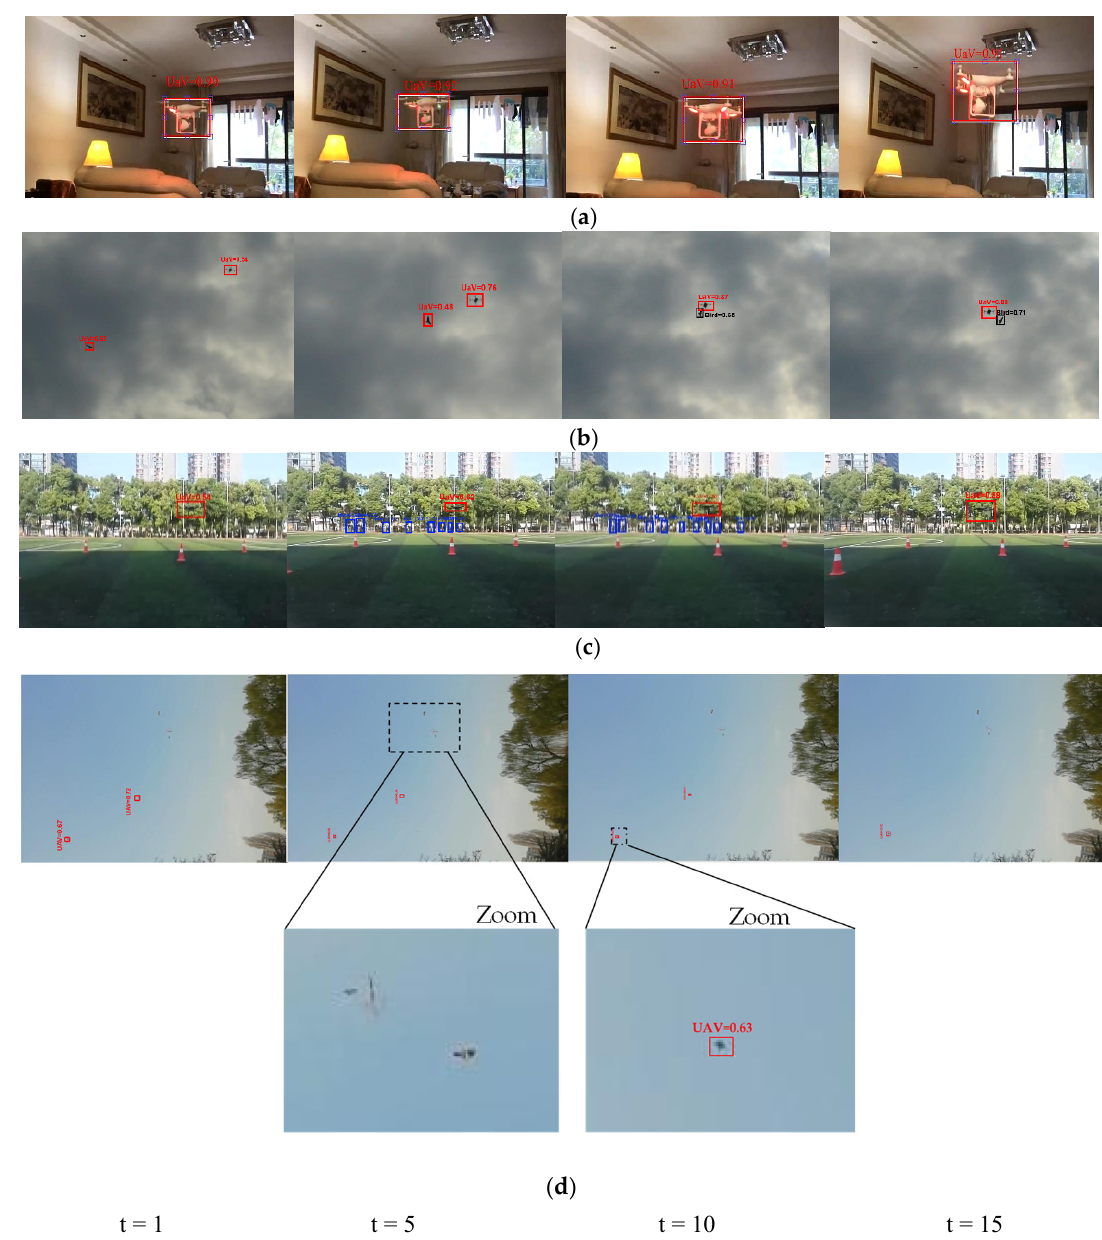
Figure 10. Detection results by MASAK method. ( a ) 3D. ( b ) 2D. ( c ) Pseudo 3D. ( d ) Tiny objects with drone-like disturbances. Table 3. Confusion matrix of MUSAK by GRU.